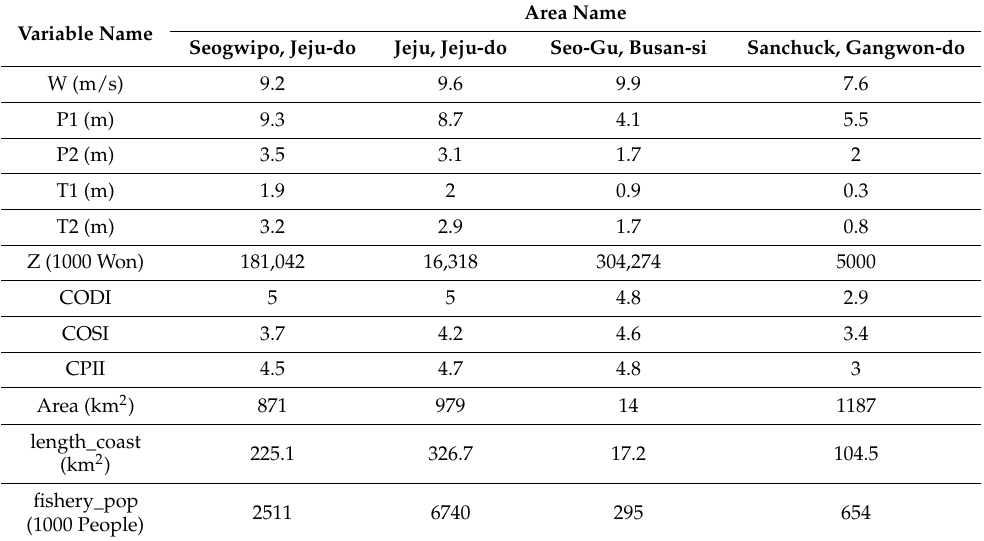
Table 4. Independent Variable Data